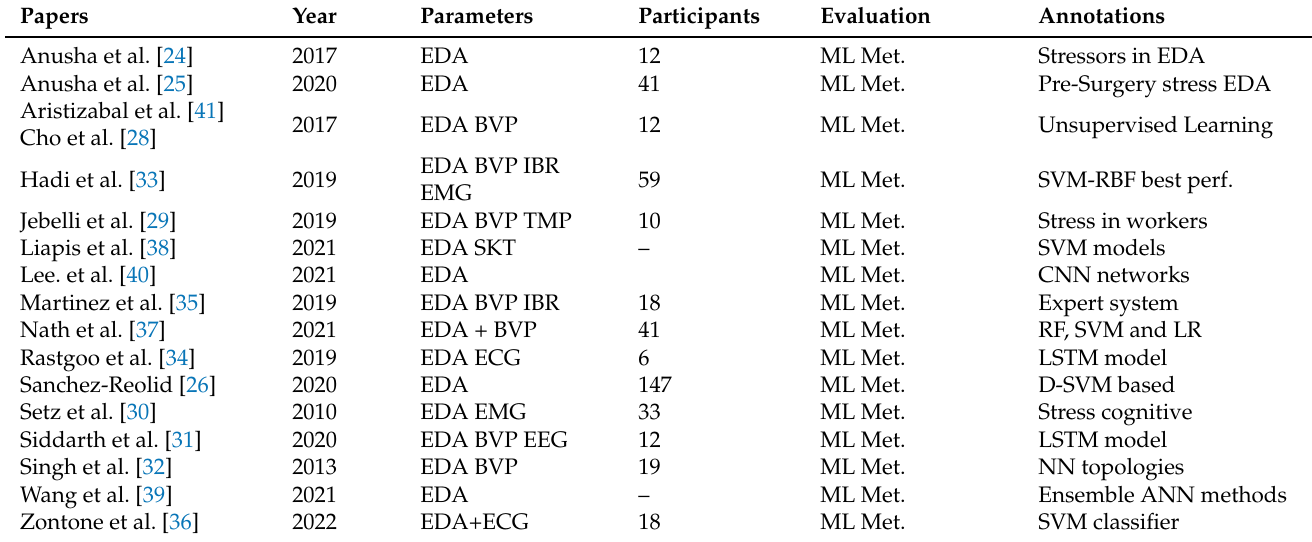
Table 5. Physiological signals used for stress